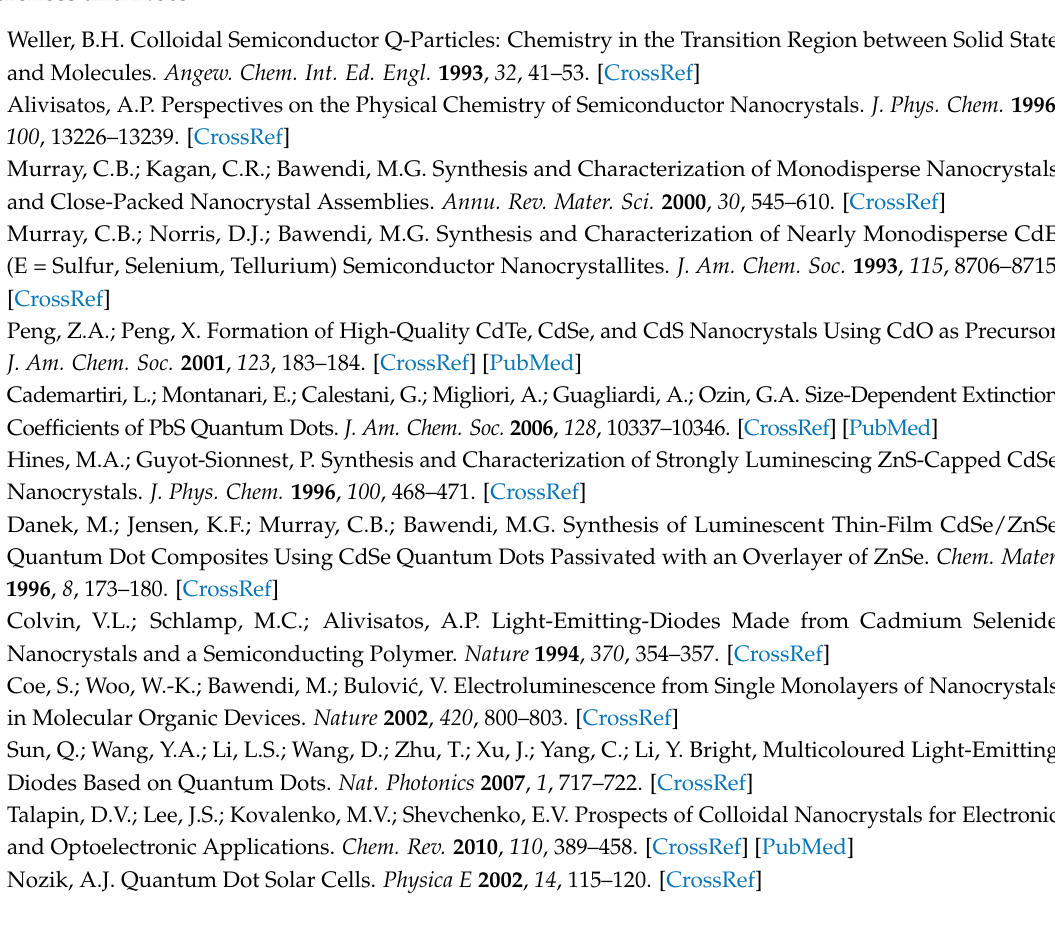
Figure S1: TEM images of AIS core NCs, AIS/ZnS NCs and AIS/ZnS:Mn NCs, Figure S2: Histograms of size distributions of AIS core NCs, AIS/ZnS NCs, AIS/ZnS:Mn NCs and AIS/ZnS:Mn/ZnS NCs, Figure S3: Absorption spectra of solutions of AIS core NCs, AIS/ZnS NCs, AIS/ZnS:Mn NCs and AIS/ZnS:Mn/ZnS NCs in toluene, Figure S4: PL spectrum of a solution of AIS/ZnS:Mn/ZnS NCs in toluene after storing for 14 months since the synthesis, and the PL color image of the solution of AIS/ZnS:Mn/ZnS NCs, Figure S5: PL decay curves of solution of AIS core NCs, AIS/ZnS NCs, and AIS/ZnS:Mn/ZnS NCs by optical excitation with 365 nm light, Figure S6: Microscopic elemental mapping images of AIS/ZnS:Mn/ZnS NCs observed by the ARM, Figure S7: Microscopic elemental mapping images of AIS/ZnS:Mn/ZnS NCs observed by the